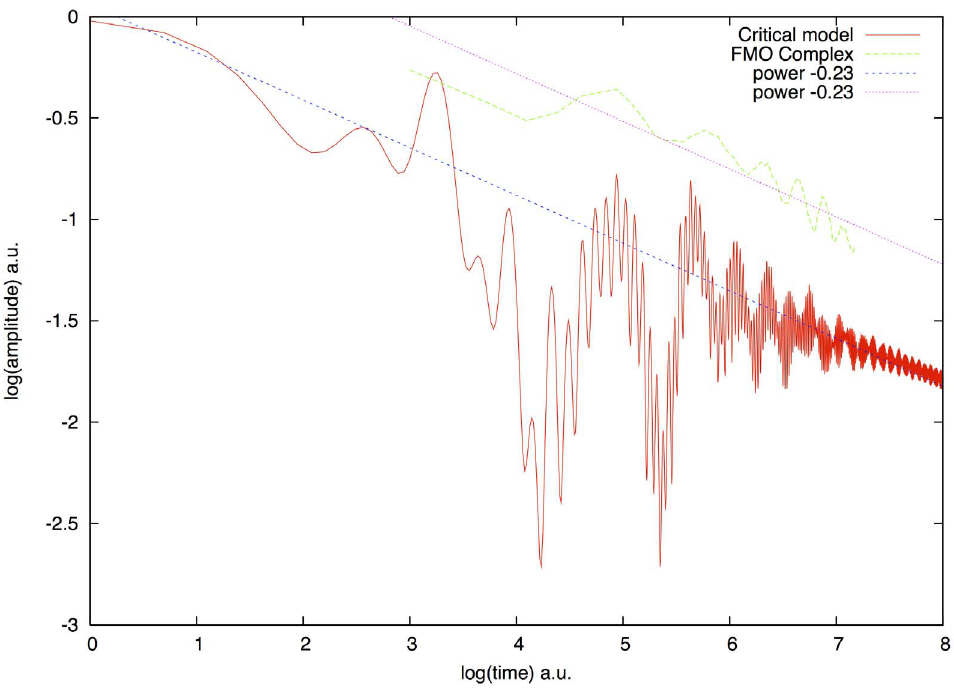
Figure 4. Power law decay of the population probability % 1,1 for the chromophore model and for the real FMO complex. The population decay for a modified version of our model is shown (red) on log-log scale at the critical point W ~ 2 , where each site is fully correlated with its next neighbors and not correlated with the rest of the chromophores. The same quantity is shown for the FMO complex (green). Time scales are in arbitrary units. Both curves oscillate around a trend which decays with the same exponent of about { 0 : 23 . While the geometry is different for FMO and the ring, both of them seem to follow the same, perhaps universal, scale free trend observed at the critical point of the MIT.